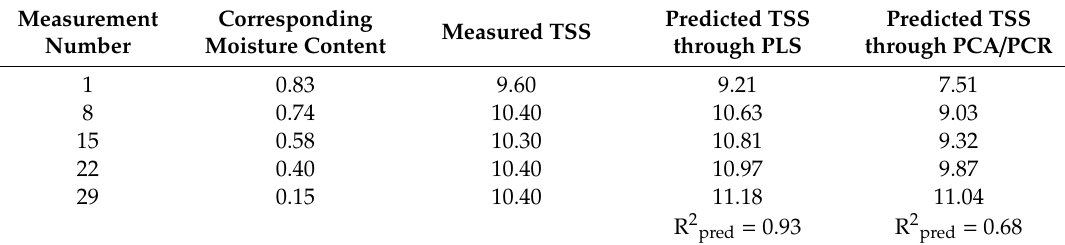
Table 3. Results of TSS prediction of the rehydrated product.